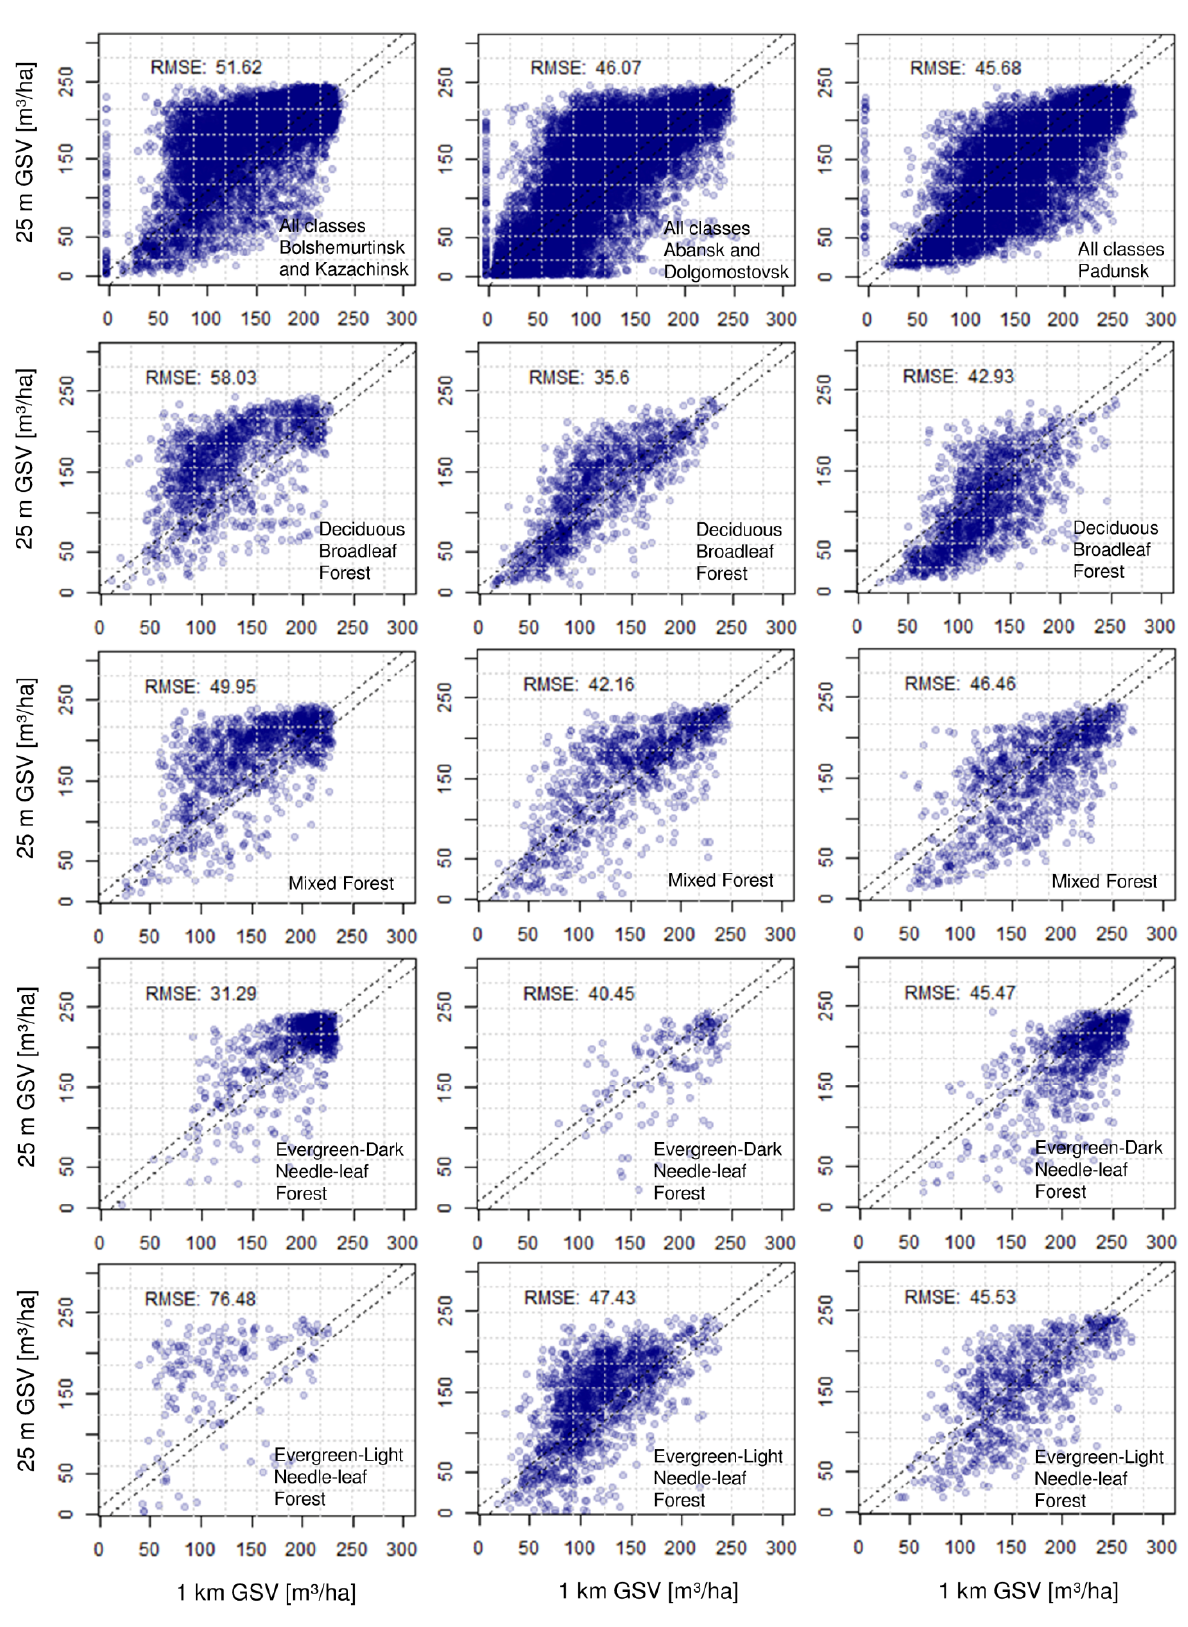
Figure 7. Scatterplots showing GSV map congruencies between 25 m and 1 km mapping scales per land cover class for three test sites in central